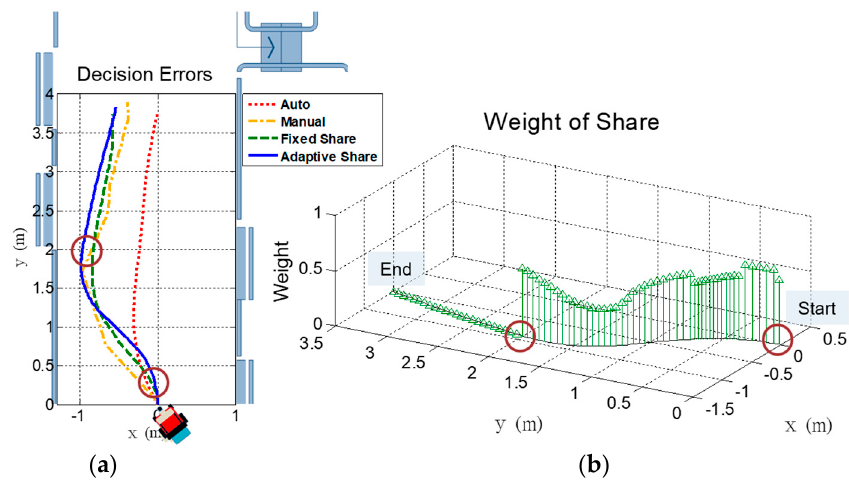
Figure 11. Experimental results of the decision error operation. ( a ) The trajectories of the four control modes. ( b ) Changes of the weights of adaptive shared control.